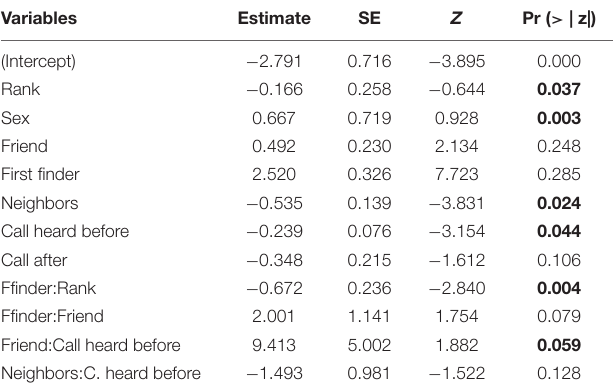
TABLE 1 | Results of the GLMM for the number of alarm calls when individuals find a snake regardless of whether there has been a previous alarm call. Variables